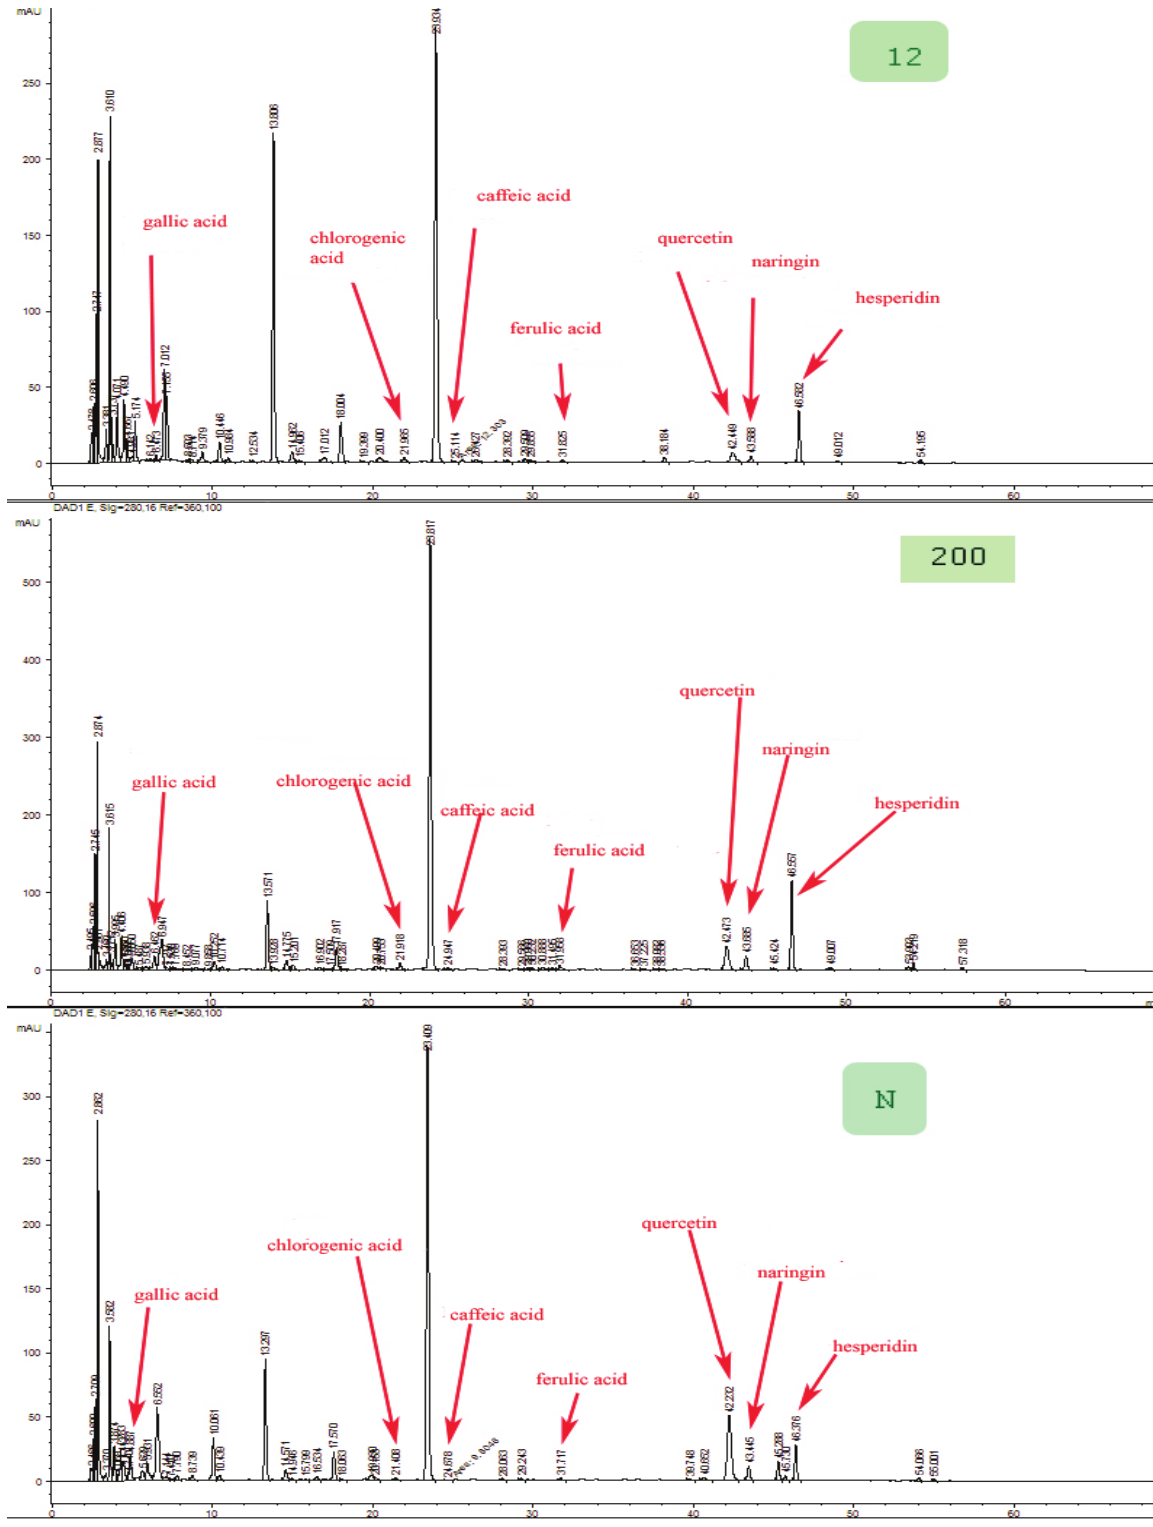
Figure 1: Representative chromatograms of extracts obtained from selected daily food rations (“12” – women from Medical University in 2008; “200” – women from Catholic University in 2009 and “N” – women from Catholic University in